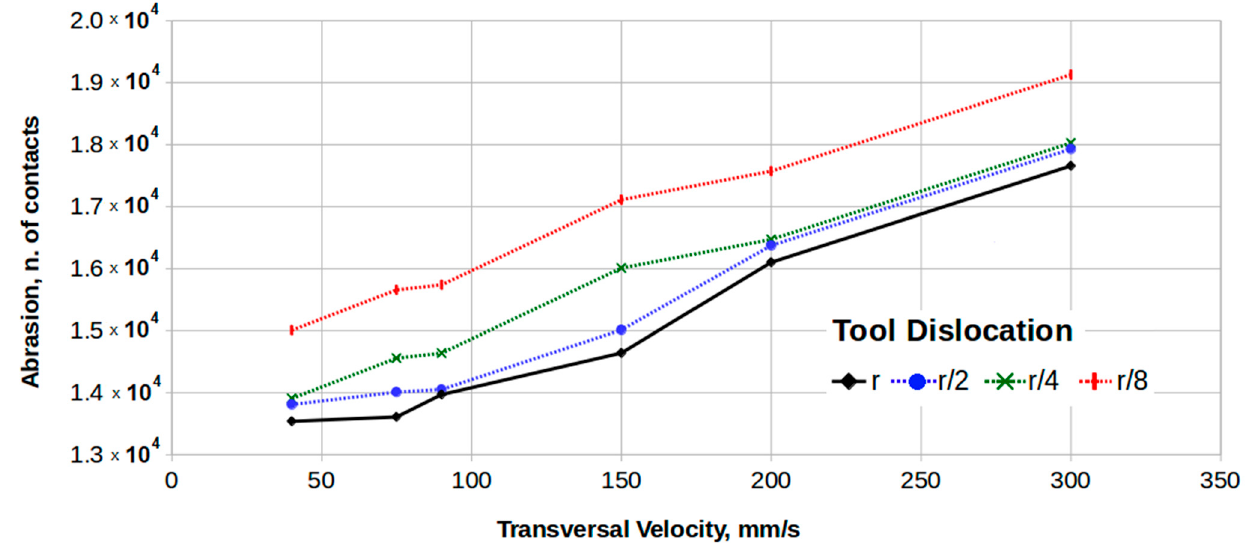
The results clearly show that a better surface quality is obtained for smaller x values when the rotating action is more effective. For x = r , the maximum attainable gloss is below 65 GU while for x = r /2, x = r /4, and x = r /8 the maximum gloss is above 70 GU; essentially the same value in the three cases. However, for x = r /8, this limit is reached sooner for lower transverse (and rotational) speeds. Simulation results (see Figure 10) for the same conditions show the same general trends, although the flat region for higher transverse velocities is not observed because the simulator simply adds abrasion contacts between the tool and the stone in a linear way, without considering any asymptotic effects.